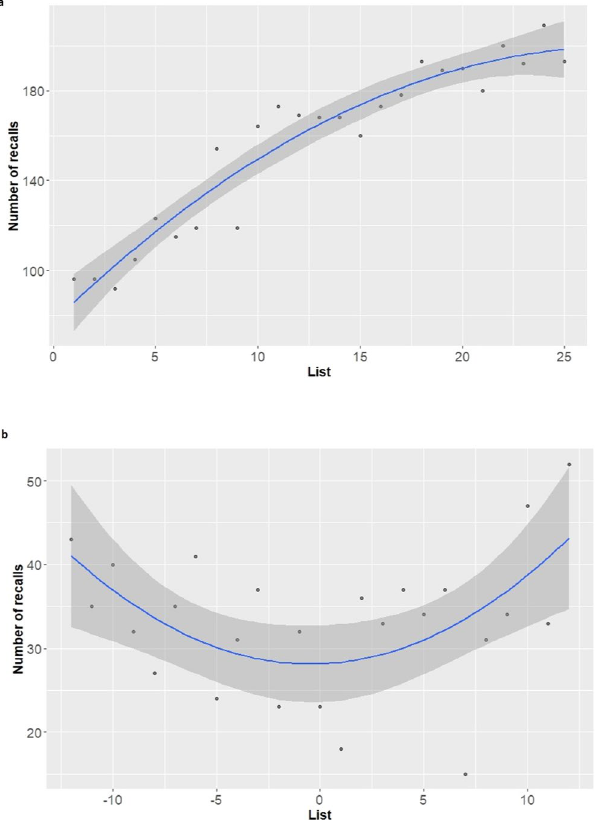
Figure 3. The list-recency effect for R and K. Total number (across all participants) of R-recalls ( a ) and K-recalls ( b ). R-recalls exhibit a classic list-recency, with higher probability of recalling items from the final lists as compared to the first and middle lists. K-recalls exhibit a U-shaped function: higher probabilities of recalling items from both first and final lists, as compared to middle lists. Blue lines denote the regression